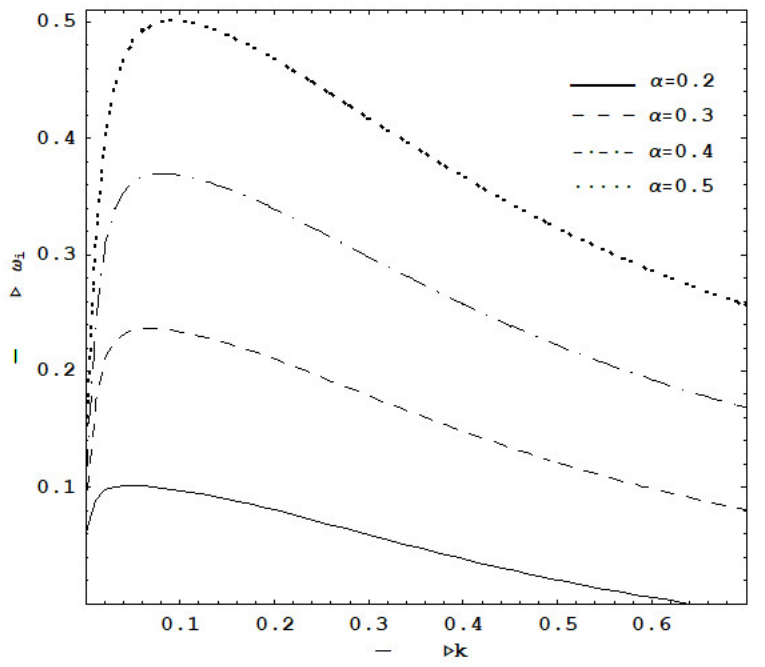
Figure 12. Variation of the growth rate ω i with the wavenumber k for different values of the mass and heat transfer coefficient, α .